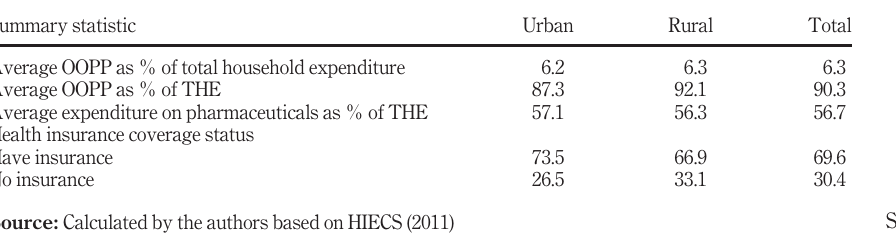
Table I. Summary